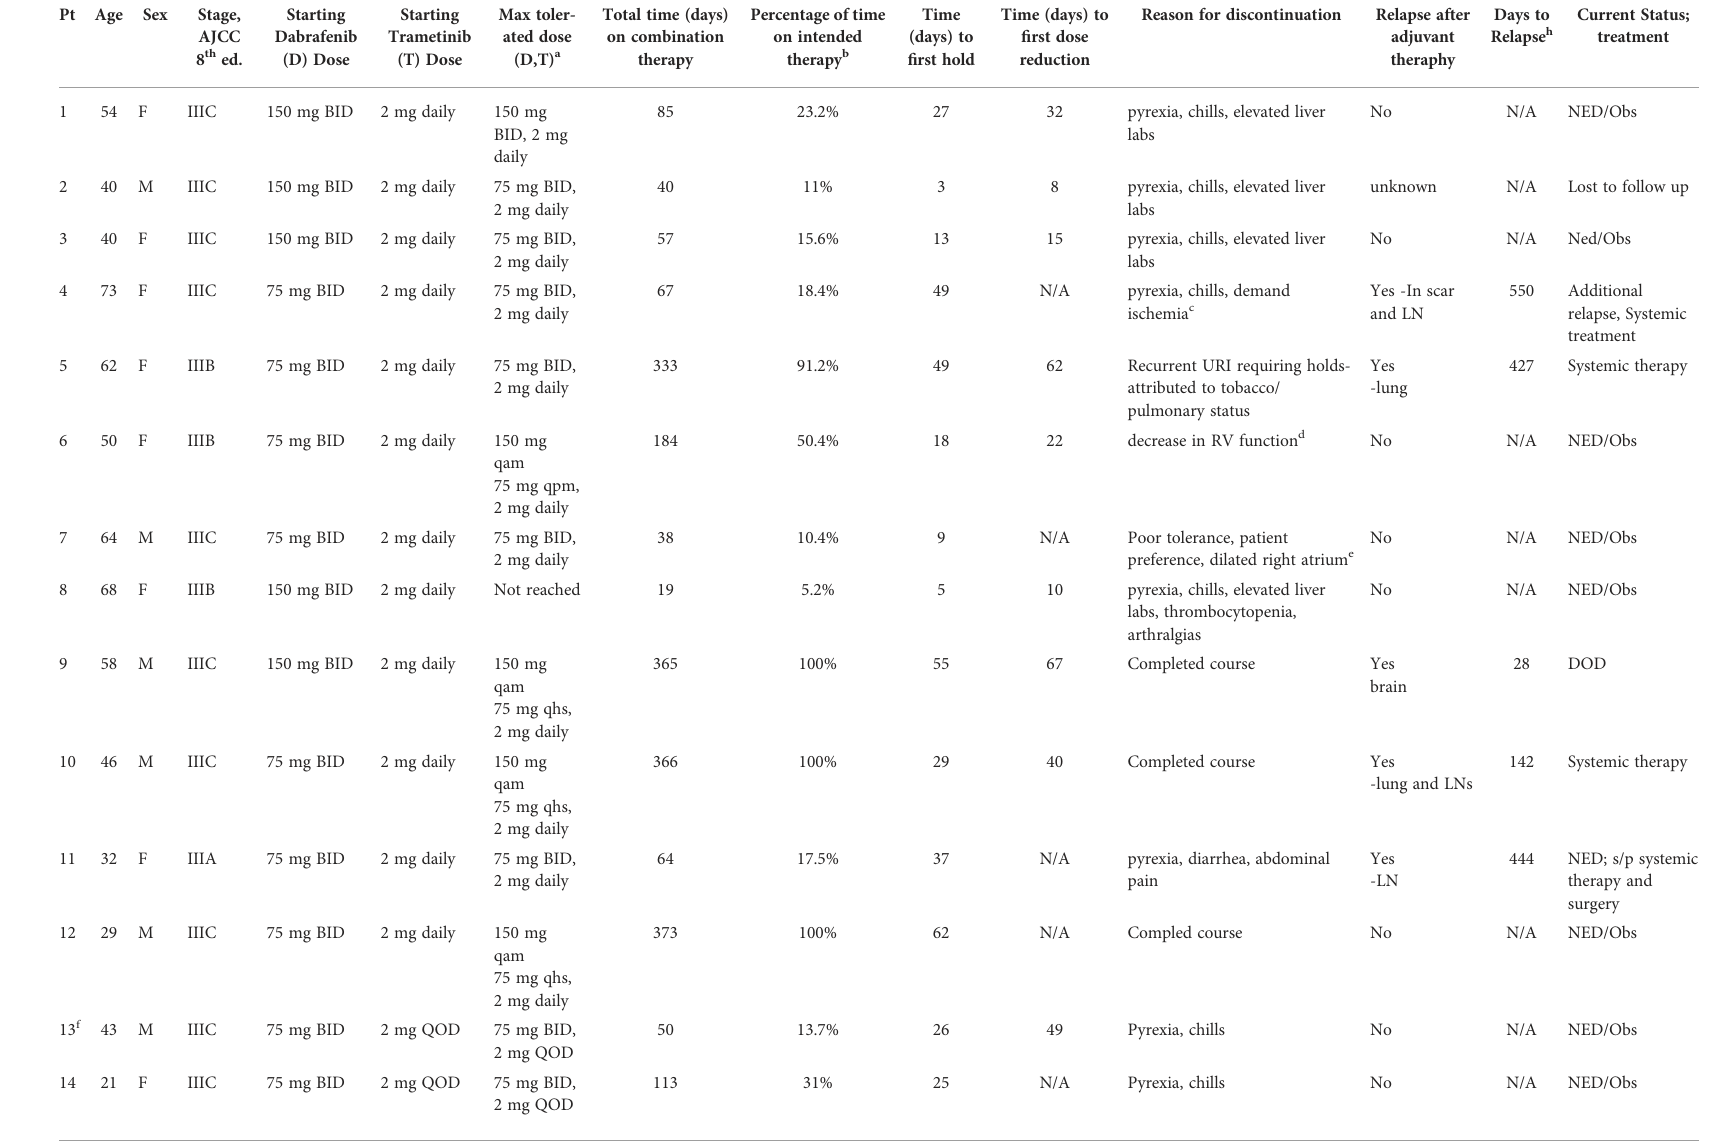
TABLE 1 Treatment